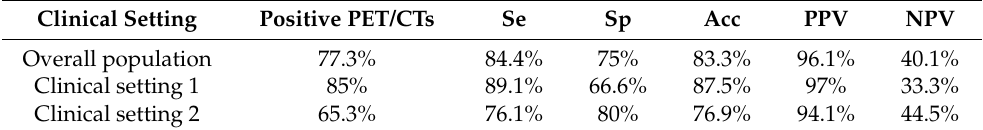
Table 2. Diagnostic performance of PET/CT in different clinical settings.